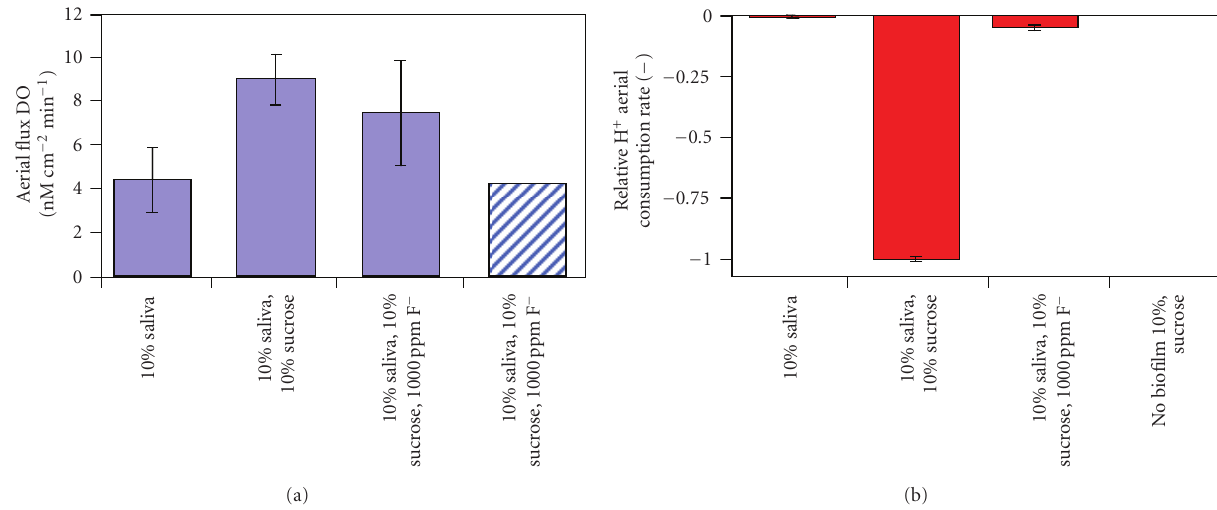
Figure 3: (a) In an S. mutans biofilm, addition of sucrose increased respiration rate by over 100% while fluoride addition reduced aerobic respiration rate by 17%. The aerobic respiration rate is shown in ex vivo interproximal plaque for comparison (hatched bar). (b) Negative H + consumption indicates acid production. The addition of sucrose increased activity by a factor of 170 while the addition of F significantly inhibited acid fermentation. Data for a sterile system are shown as a negative control.